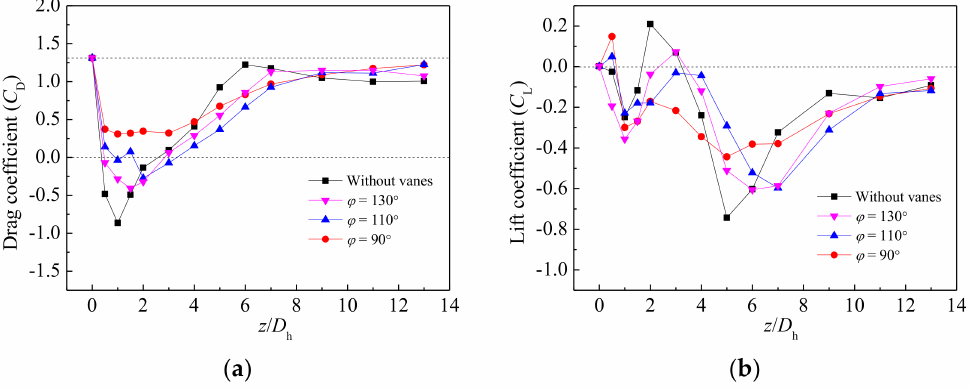
Figure 18. Drag coefficients ( a ) and lift coefficients ( b ) with different angle of the vanes at R =